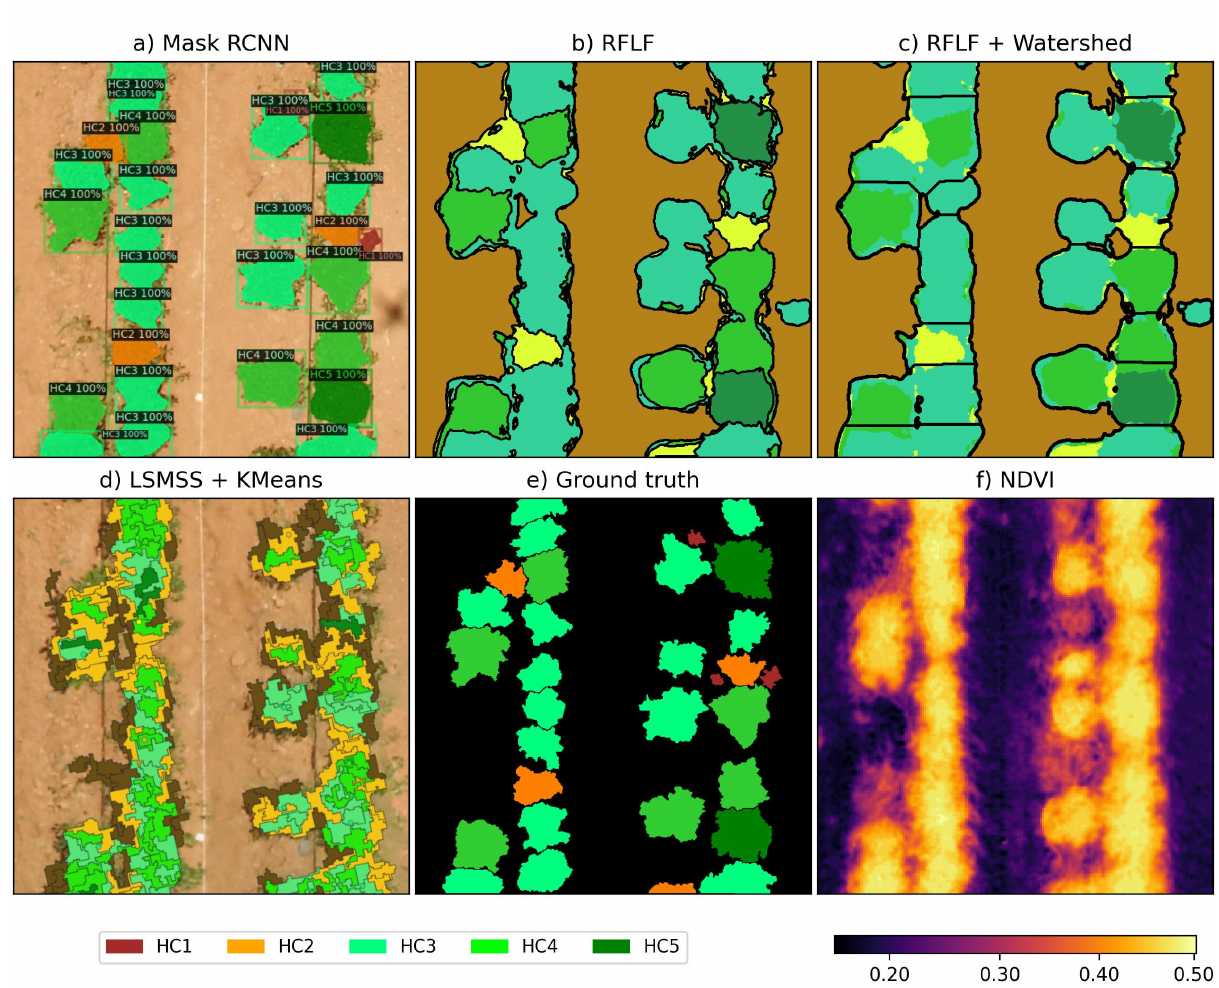
Figure 11. Tile level predictions for different segmentation procedures. Mask RCNN, and RFLF methods were trained with the same dataset samples. Classifiers for LSMSS and NDVI are